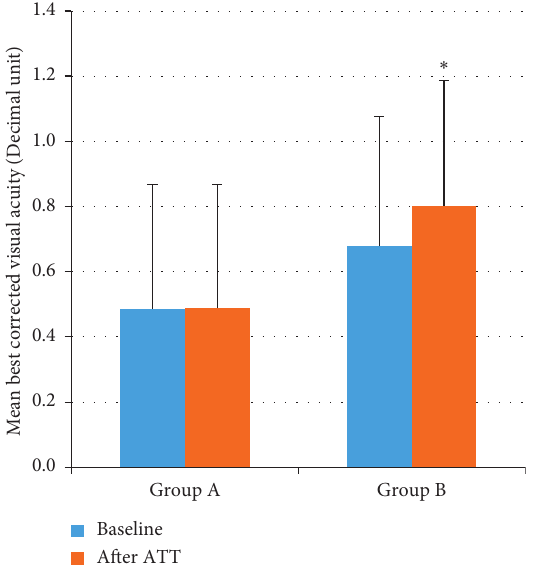
Figure 2: Mean best corrected visual acuity at baseline and after antitubercular treatment in group A and